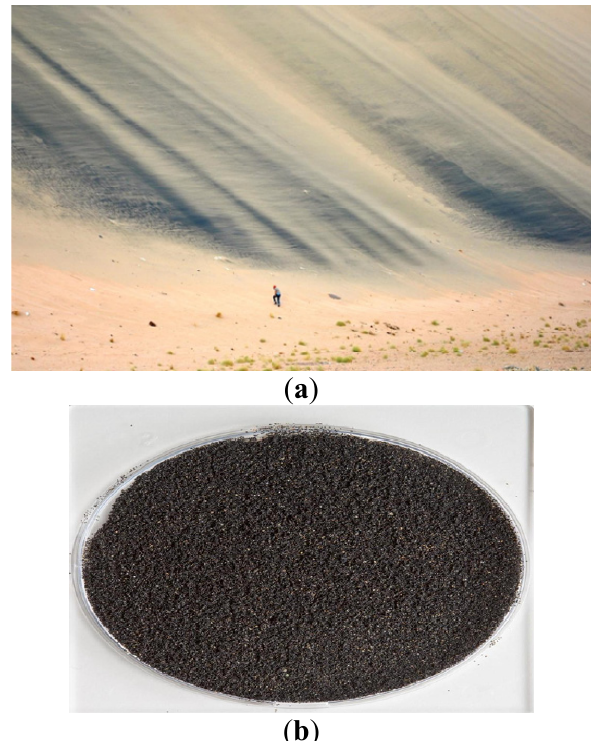
Figure 1. ( a ) Photograph of black sand on Douf Mountain, Badr, Saudi Arabia; ( b ) Photograph of black sand collected from Douf Mountain on February